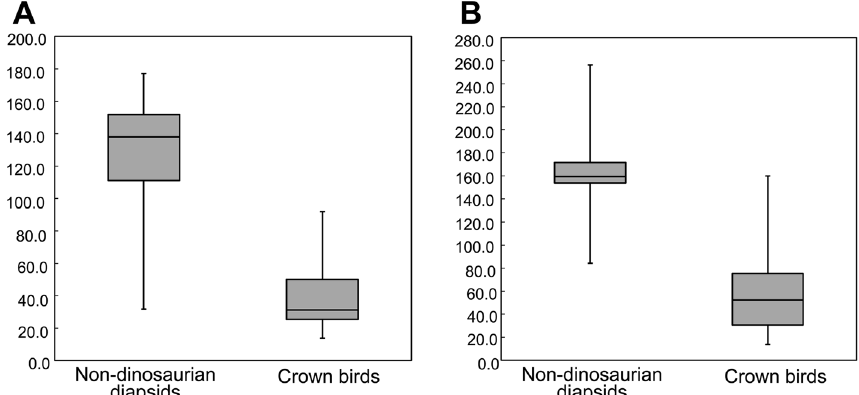
Fig. 3 Comparison of preserved elbow and wrist-joint angles between the non-dinosaurian diapsids and crown birds. A Elbow-joint angles. B Wrist-joint angles. Measurements were obtained from 71 non-dinosaurian diapsid and 35 crown bird articulated fossil